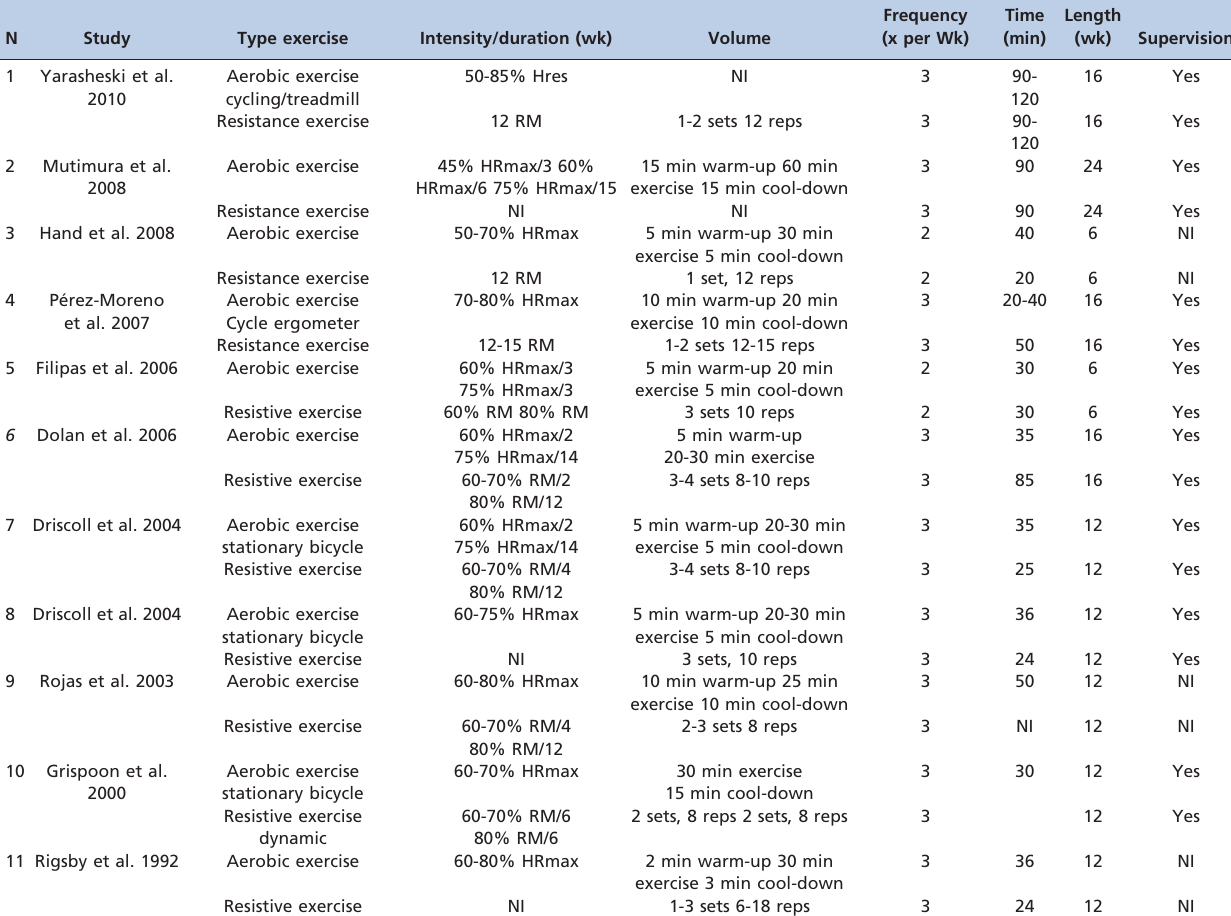
Table 5 - Characteristics of the experimental intervention (concurrent training) in the trials included in the